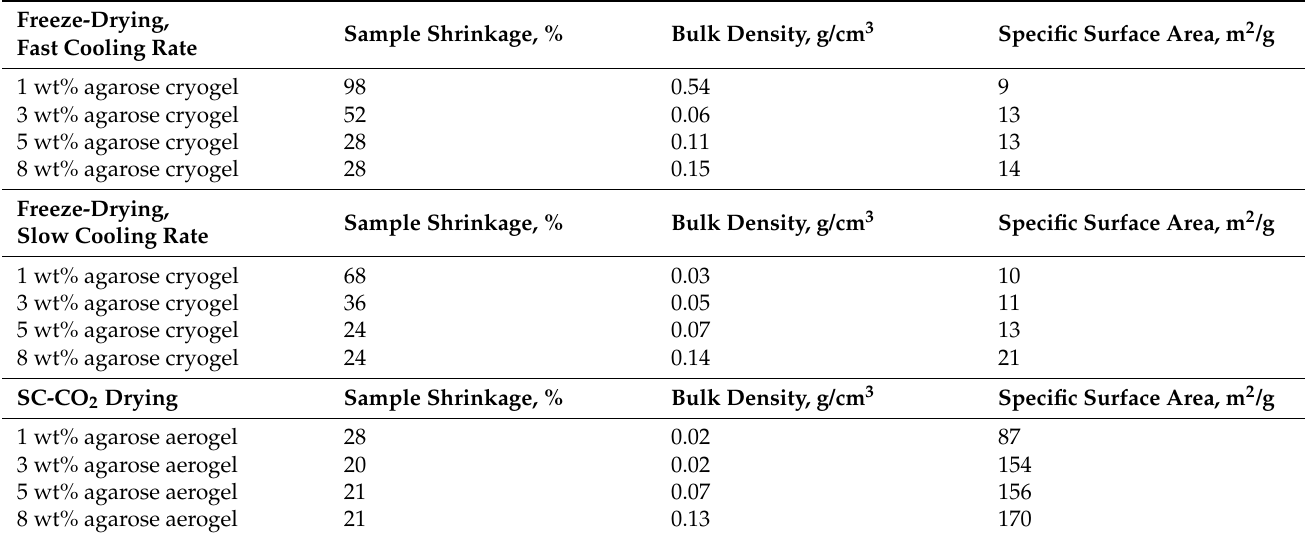
Table 1. Percentage of shrinkage, bulk density and specific surface area measurements of the agarose cryogels and aerogels produced in this